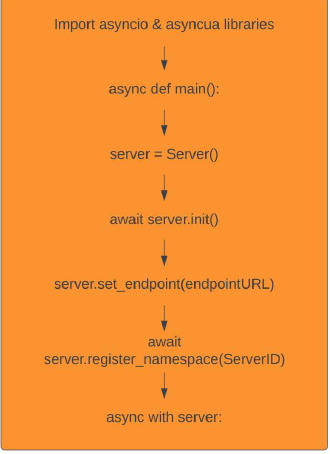
Figure 4. Configuration process of the OPC UA Server.